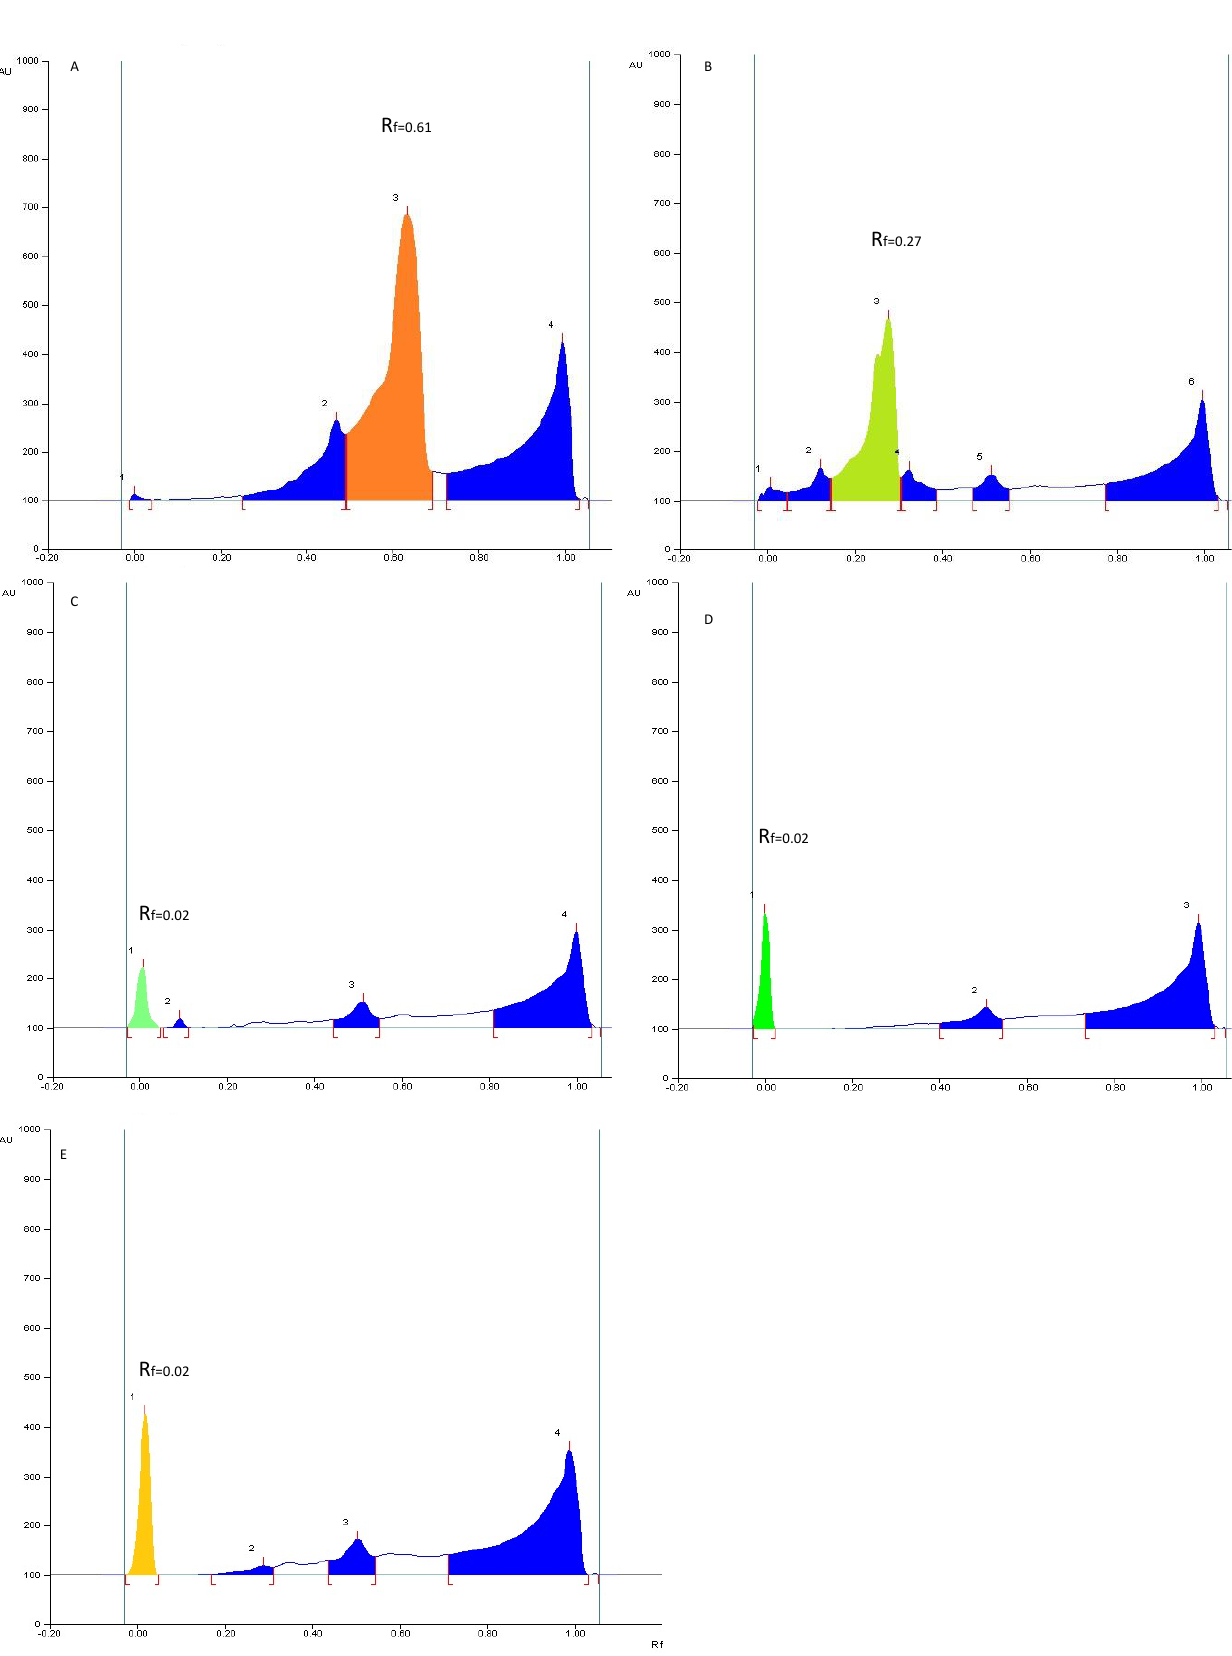
Figure 5. Densitograms of oleanolic acid ( A ), senegenin ( B ), solanine ( C ), digitonin ( D ), and glucose – fructose ( E ) at 600 nm after visualization with anisaldehyde-H 2 SO 4 .